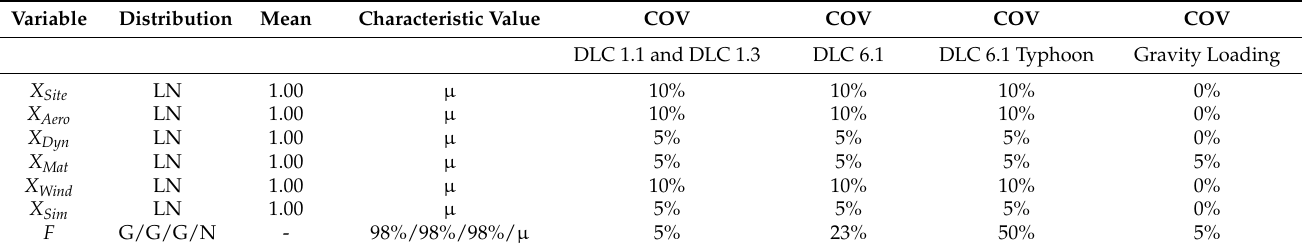
Table 1. Stochastic model for the load variables. Abbreviations are used for the distributions: LN: Lognormal, G: Gumbel, N: